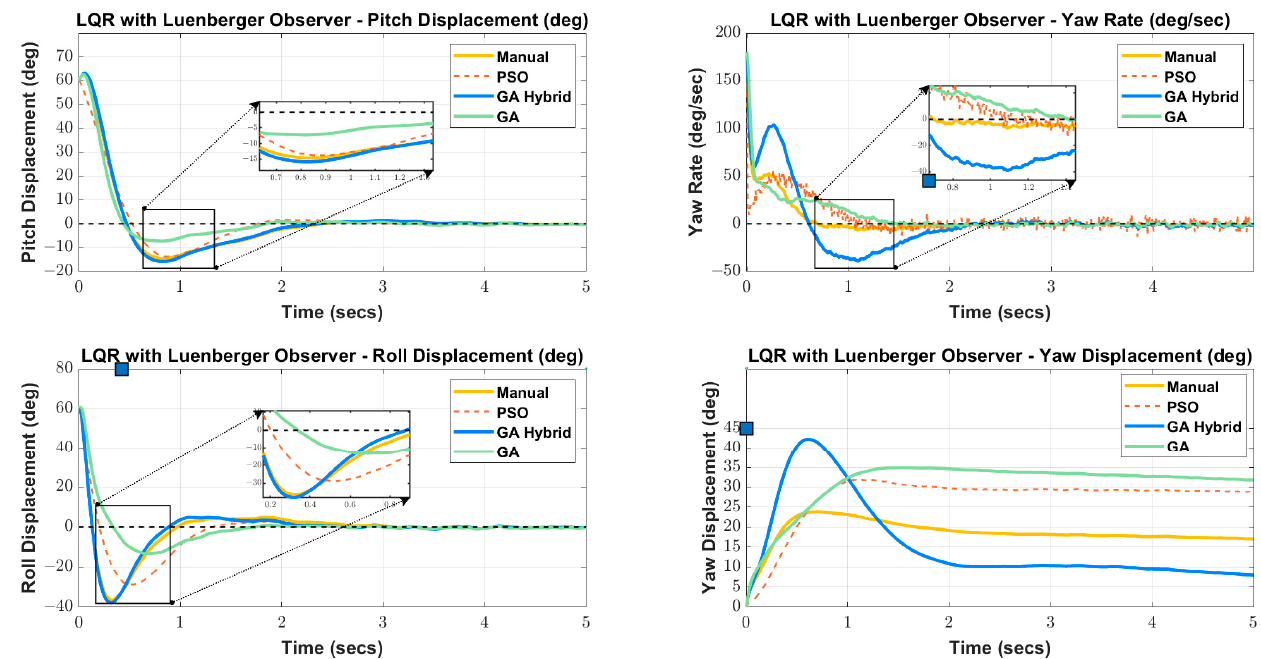
Figure 11. Full State Feedback response for Manually tuned, PSO and GA.